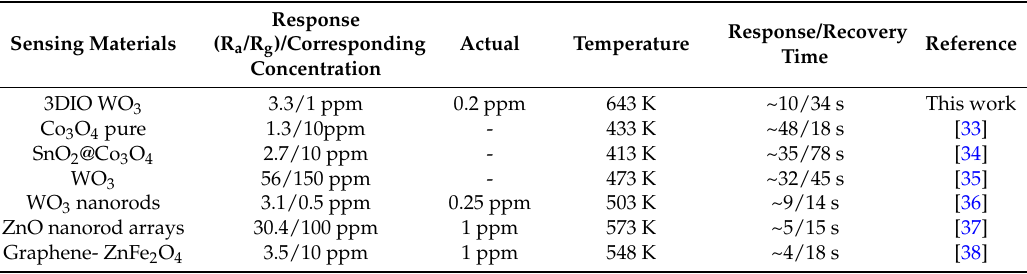
Table 1. Comparison of the acetone gas sensing performances of some reported metal oxide sensors and the 3DIO WO 3 sensor in this study.